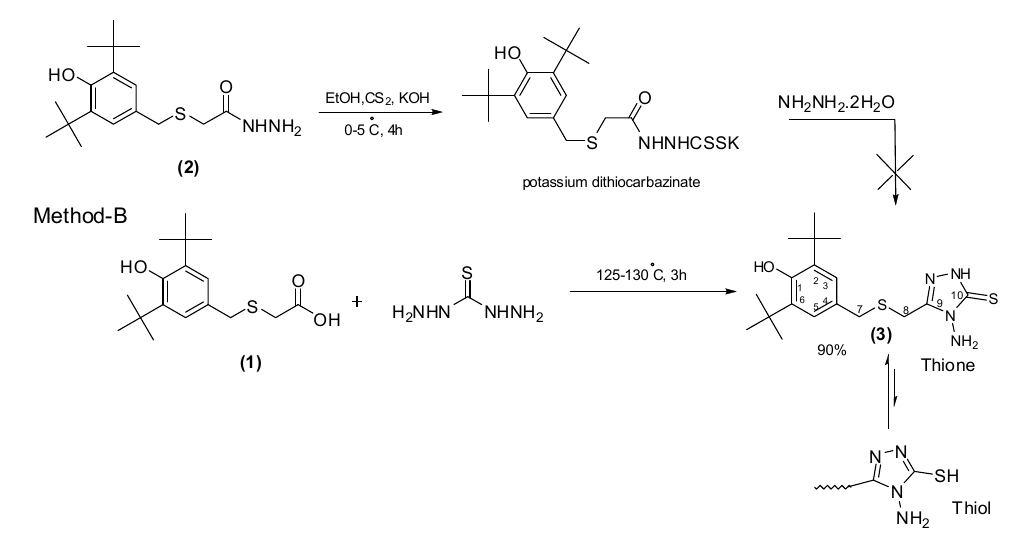
Scheme 1. Synthetic scheme for the formation of 4-amino-3-((3,5-di- tert -butyl-4-hydroxybenzylthio)methyl)-1 H -1,2,4-triazole-5(4 H )-thione ( 3 ).